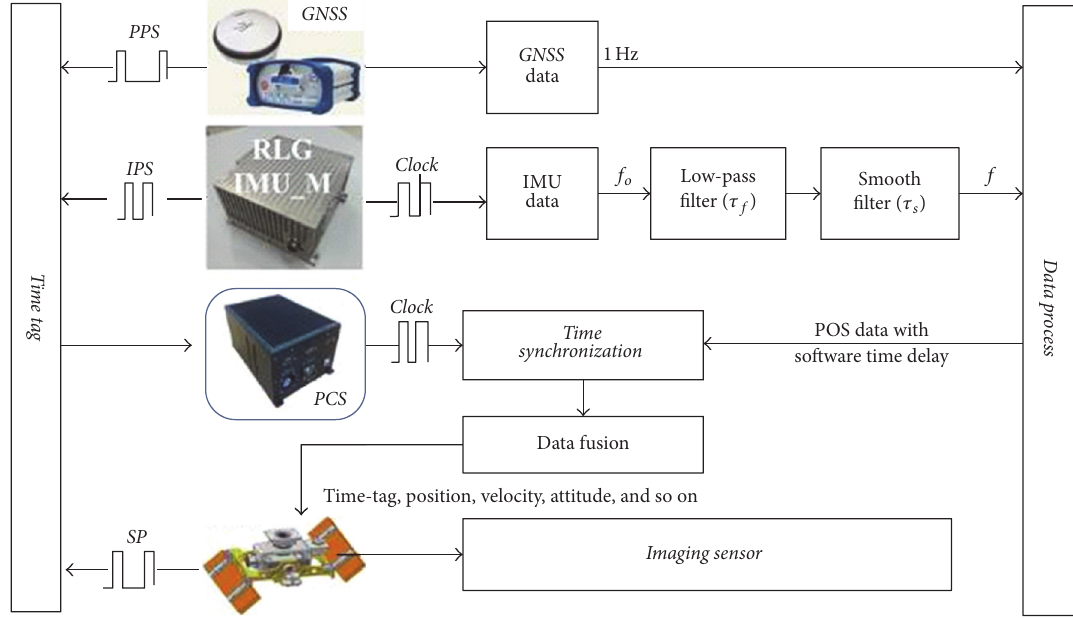
Figure 3: Timing and synchronization principle of